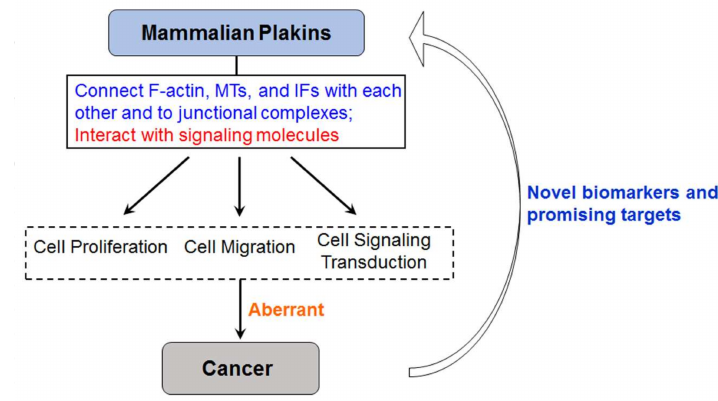
Figure 4. Mammalian plakins are novel biomarkers and promising targets for cancer diagnosis and therapy, given their versatile biological